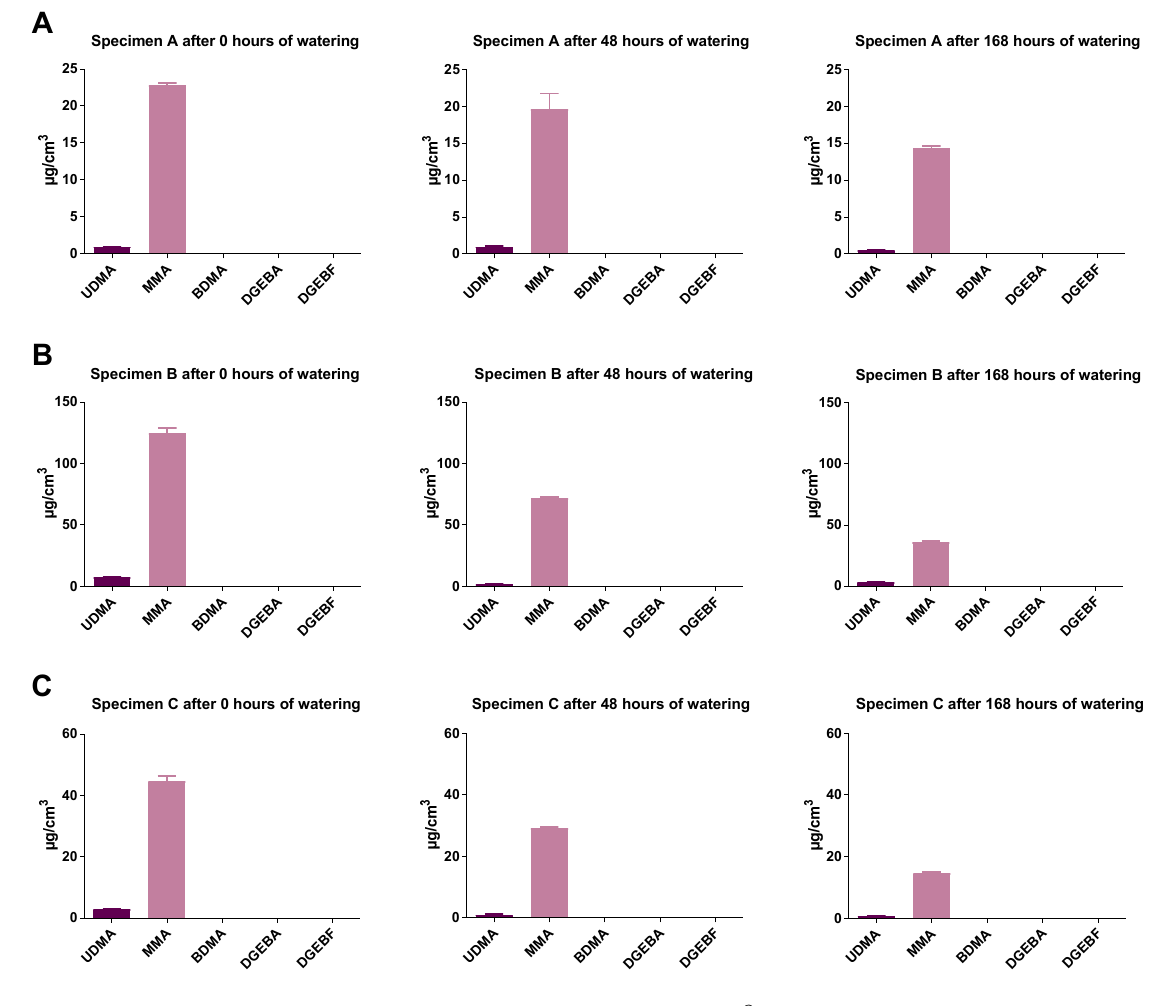
Figure Figure 8. Monomer release from Orthocryl ® specimens extracts of ( A ) test specimens A (15 mm × 0.5 mm), ( B ) test specimens B (50 mm × 1.0 mm) or ( C ) test specimens C (50 mm × 3.0 mm) under different soaking conditions. Shown are the total amounts of monomers released in relation to the respective specimen volume. The test specimens were stored in distilled water at room temperature for 0, 48 or 168 h followed by a 24 h storage in cell culture medium (DMEM, Dulbecco’s Modified Eagle Medium) under shaking conditions. The DMEM eluates were used undiluted (100%) to de- termine the monomers by GC-MS. UDMA, urethane dimethacrylate; MMA, methyl methacrylate;